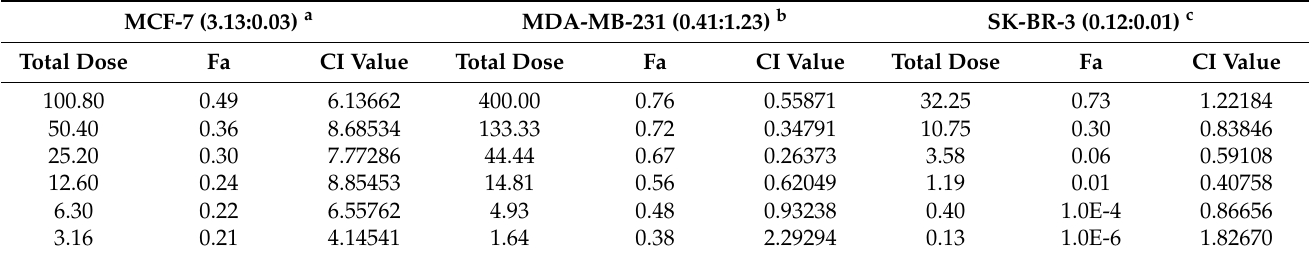
Table 10. Fa and CI values for actual experimental points of cisplatin combined with